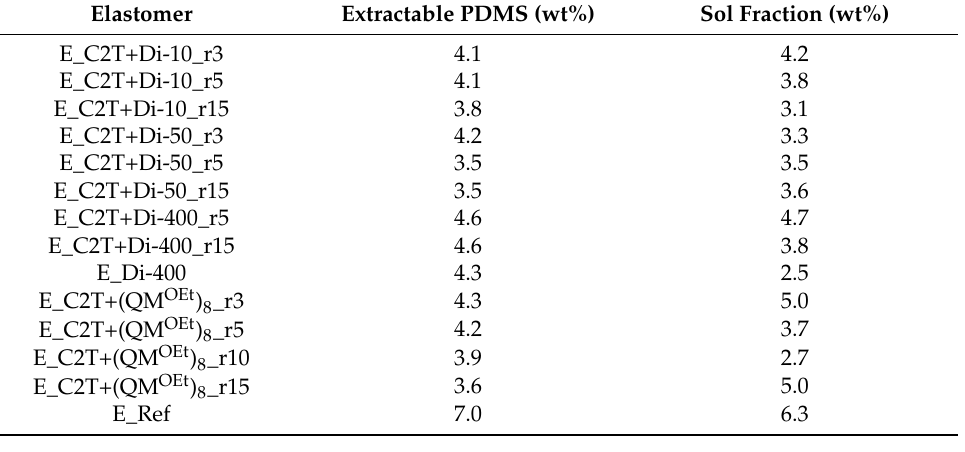
Table A4. Amounts of extractable PDMS (determined by 1 H NMR) and sol fraction (determined from the weight loss) of the stable elastomer films. Elastomer